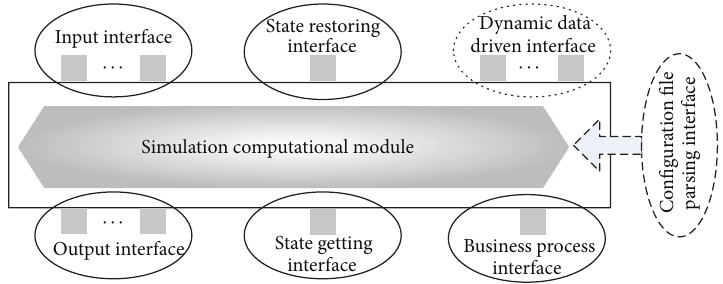
Figure 2: Reusable component model